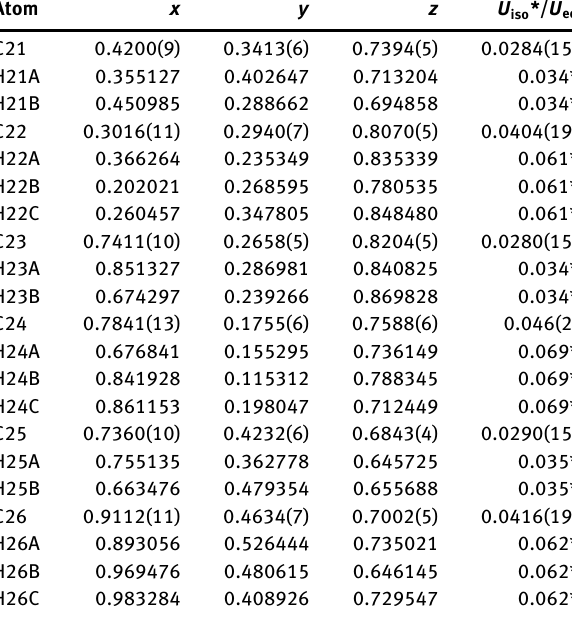
Table 2: Fractional atomic coordinates and isotropic or equivalent isotropic displacement parameters (Å 2